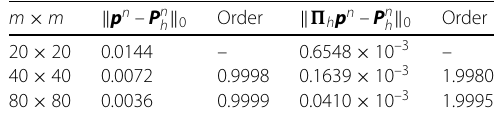
Table 7 Numerical results at t = 0.75 with τ = 5 h